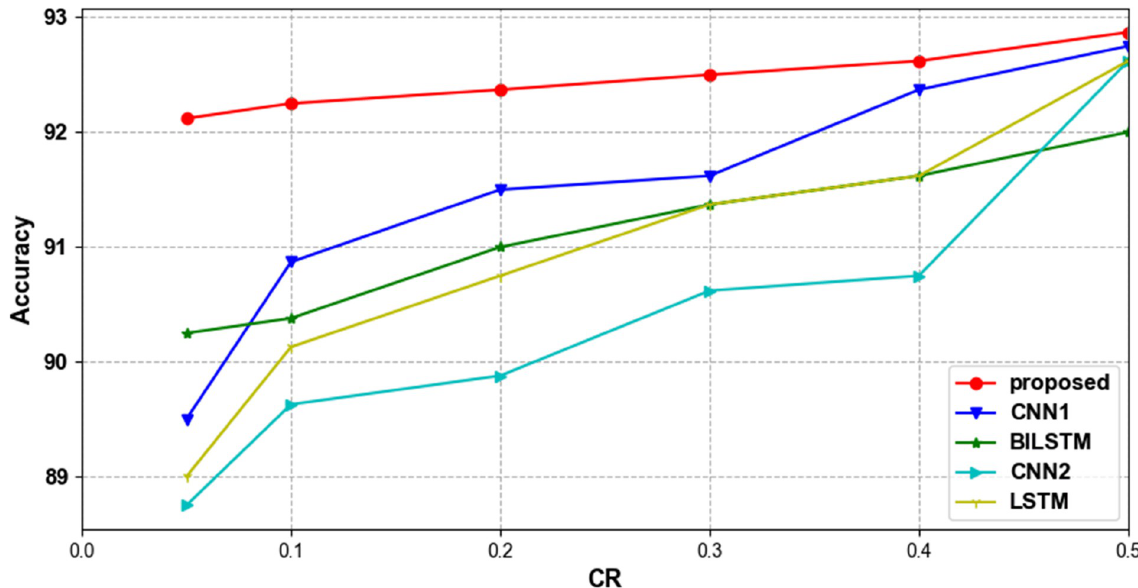
Fig 15. Accuracy trends using different classification methods at different compression ratios in the TianChi ECG signal database.